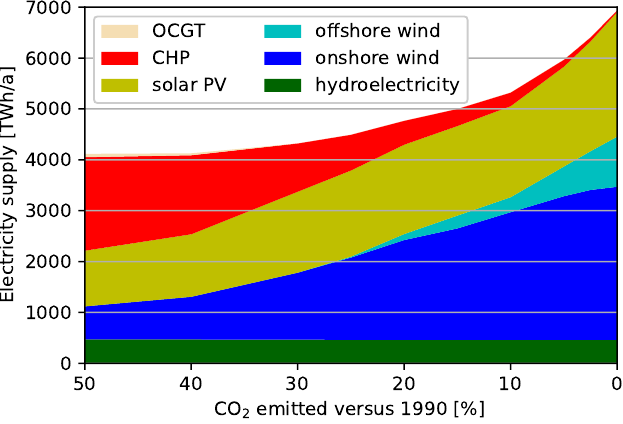
Figure 6. Breakdown of electricity supply by technology.